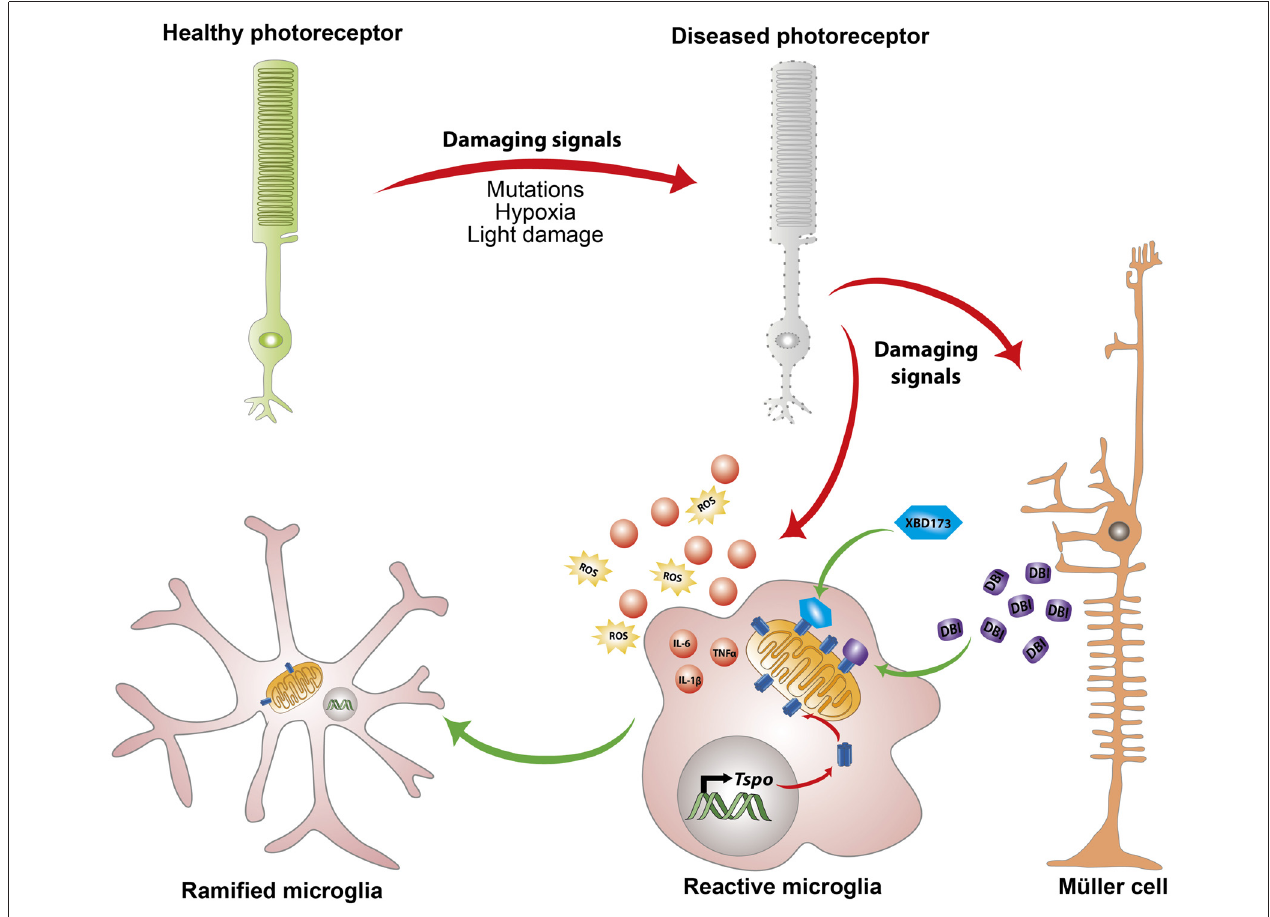
FIGURE 1 | Endogenous and exogenous translocator protein 18 kDa (TSPO) ligands alleviate chronic microglia activation. In response to pathological signals from dying photoreceptors, Müller cells upregulate the expression and secretion of the endogenous TSPO ligand Diazepine binding inhibitor (DBI) protein.